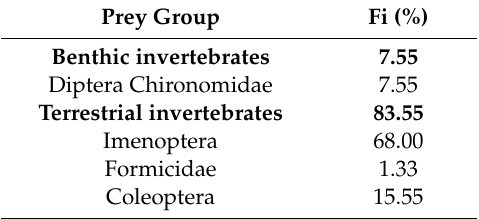
Table 6. Diet of Salvelinus fontinalis ; Fi = frequency of occurrence (in percentage). Prey Group Fi